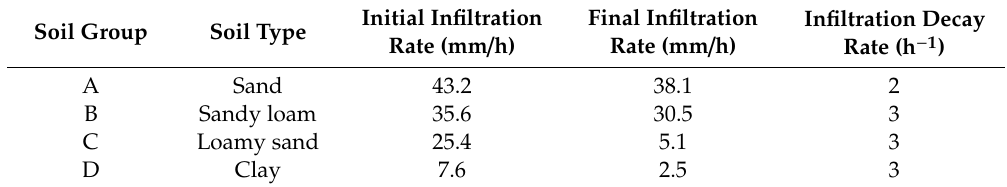
Table 1. Horton’s infiltration parameters by soil group (minimum recommended